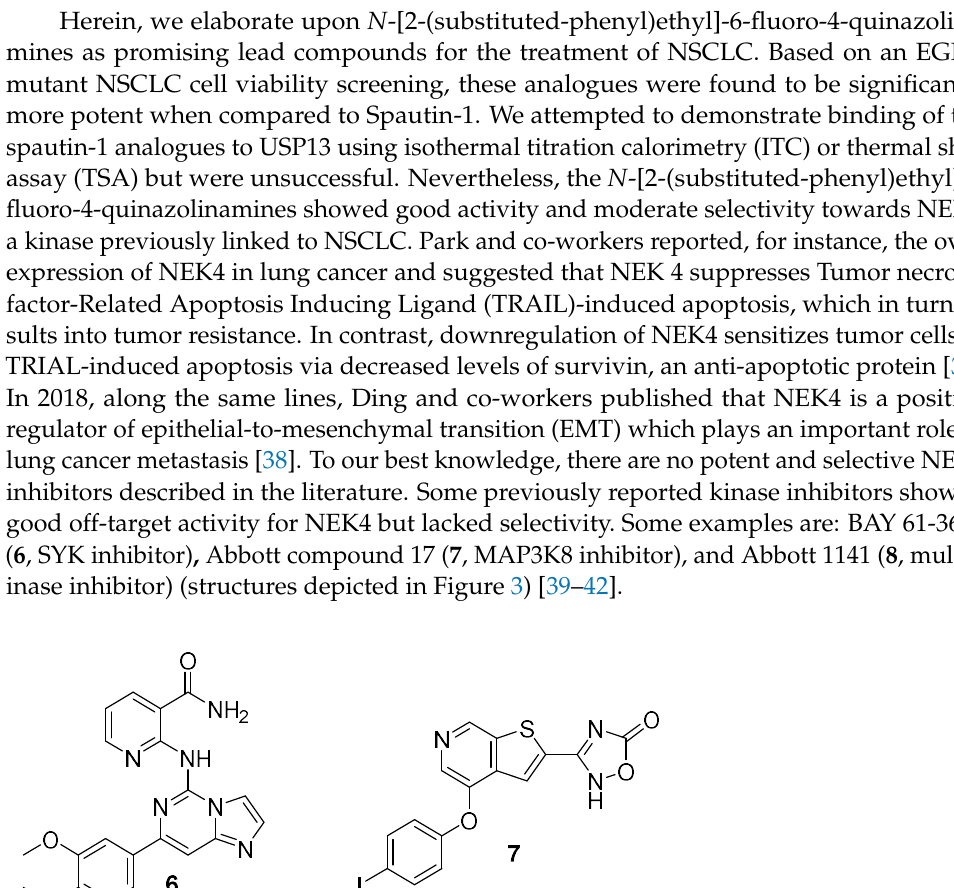
Figure 3. Non-selective NEK4 inhibitors reported in the literature so far.